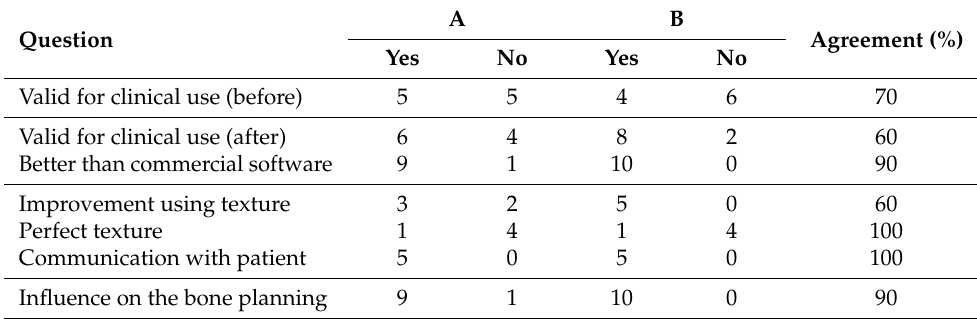
Table 5. Summary of binary questions, answers count for all patients of each surgeon (A and B) and percentage of agreement between them.